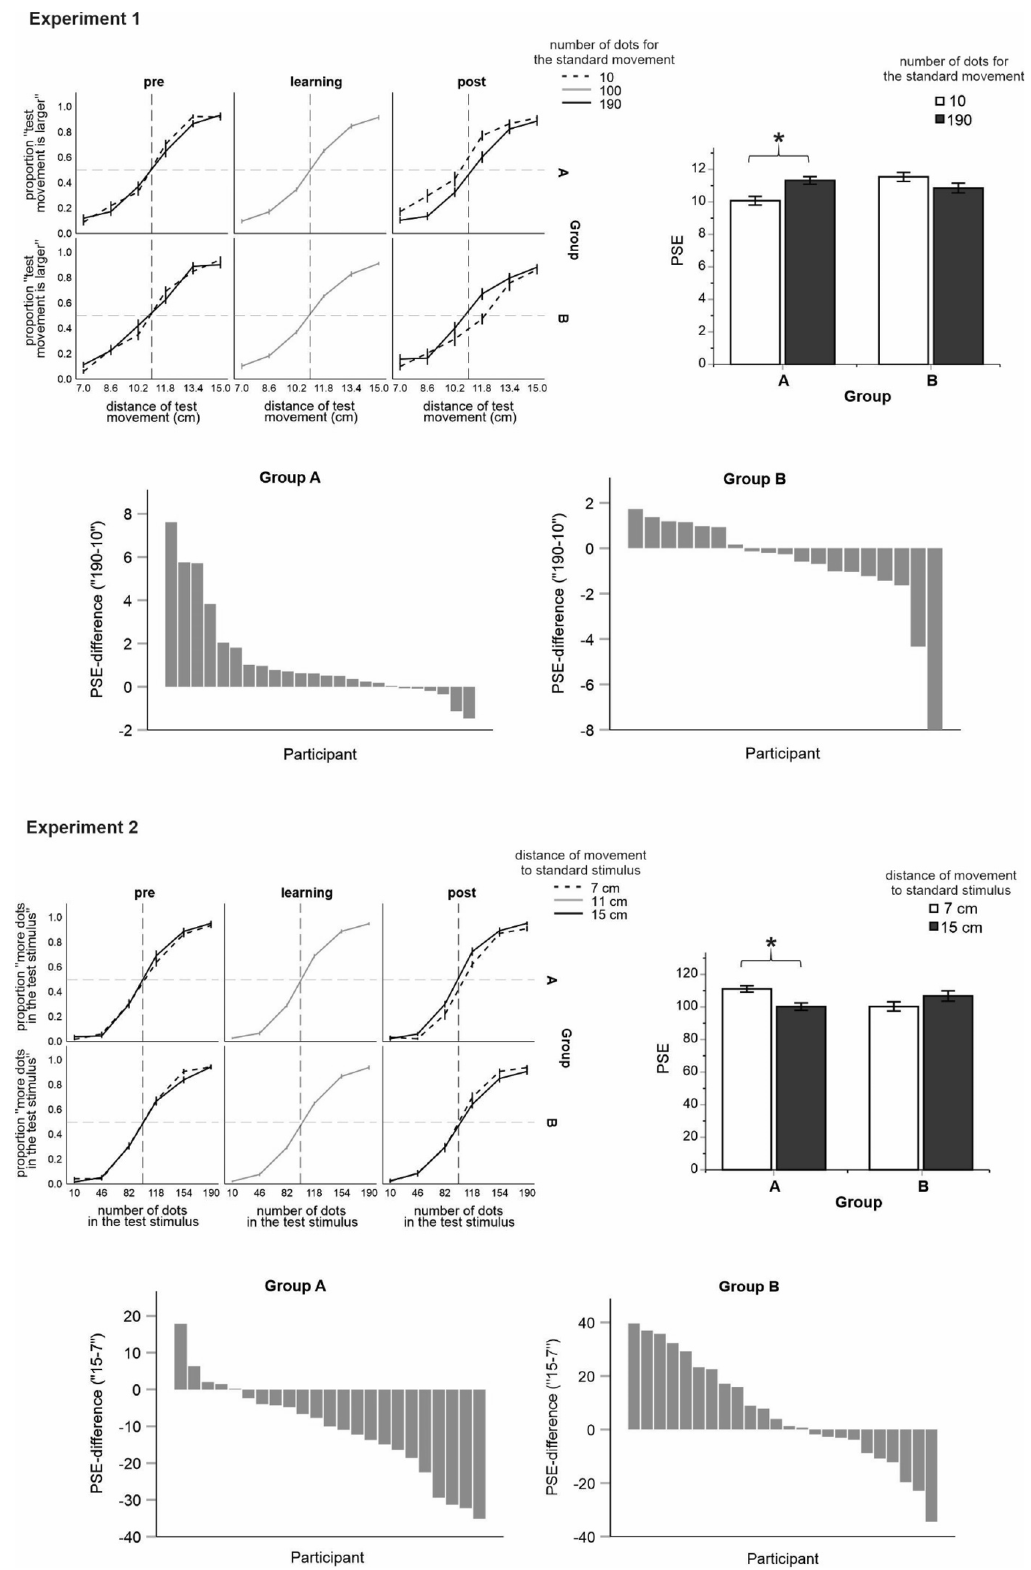
Figure 3. Results of Exp.1 (upper part) and Exp.2 (lower part). Shown are mean judgment data for all conditions (line graphs), mean PSE values for the post learning phase (graphs including white and black bars), and the effects (i.e. PSE differences) of the varying number of dots (Exp.1) and of the varying movement distance (Exp.2) on judgment behavior for each individual participant (graphs including gray bars sorted by their magnitude). Error bars are standard errors. Asterisks denote statistical significance (p <